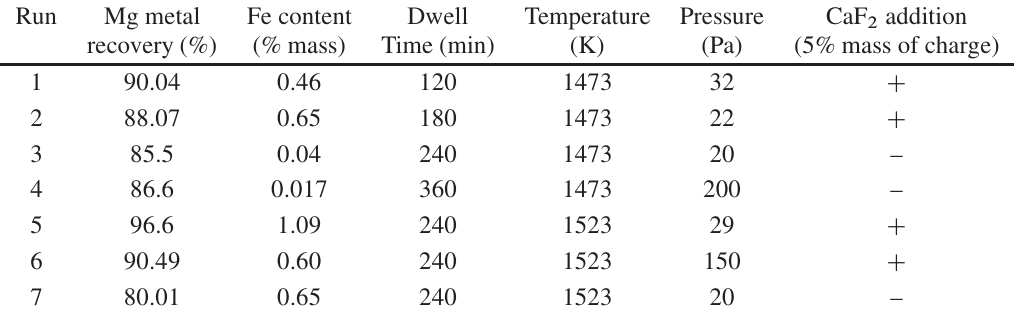
Table 5. Mg metal recovery and Fe content (% mass) of reduction experiments.